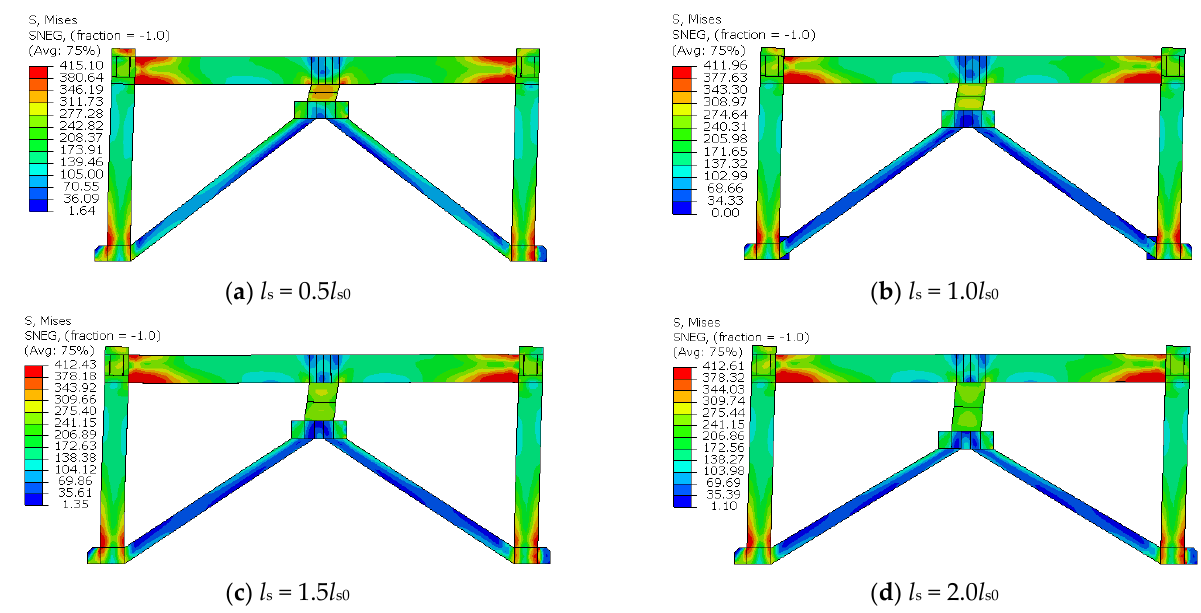
Figure 16. Stress nephograms of a steel frame for different l s values.